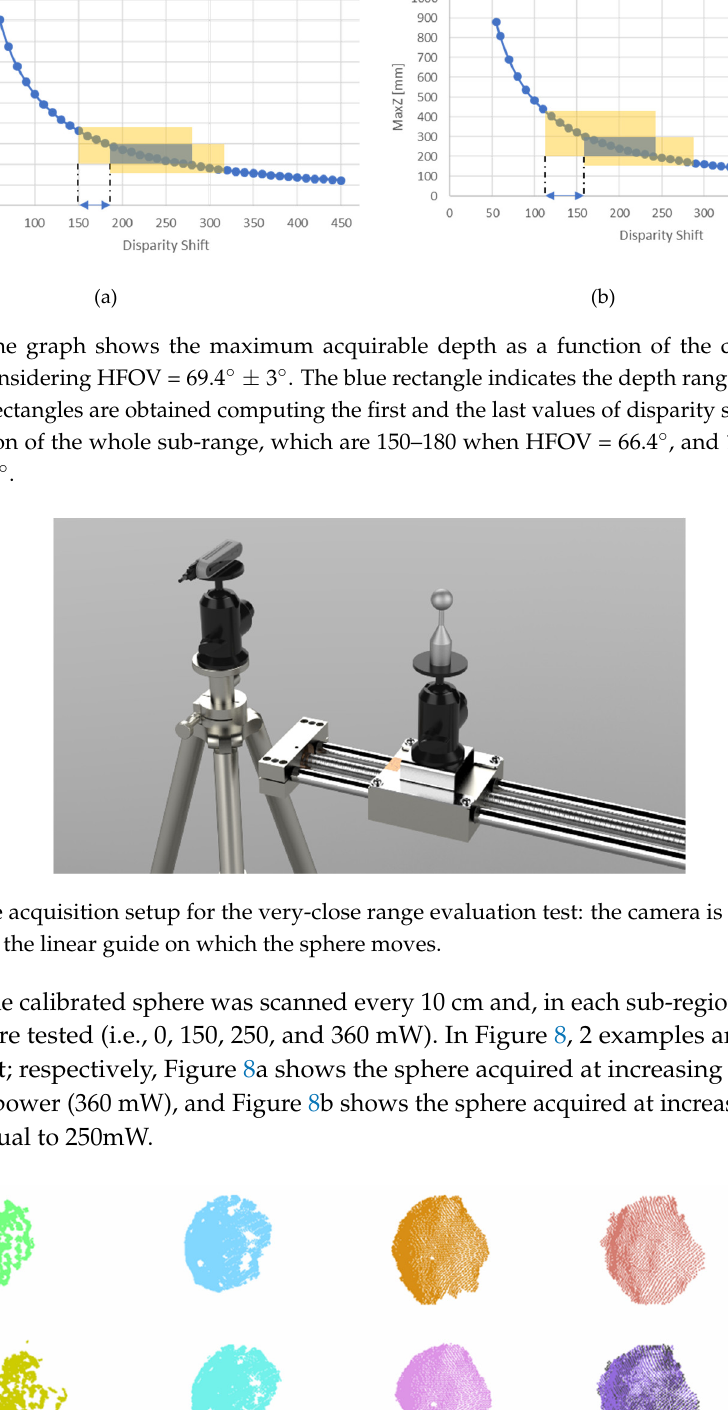
Table 5. The tested value of disparity shift and laser power for each sub-range.